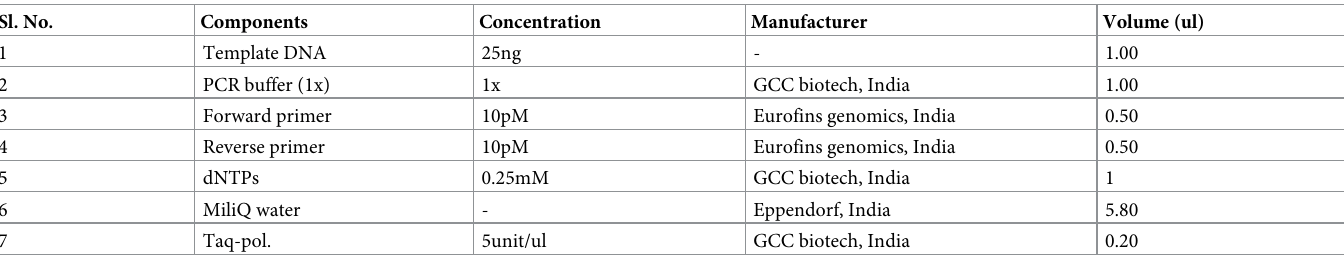
Table 6. PCR reaction mixture. Sl.